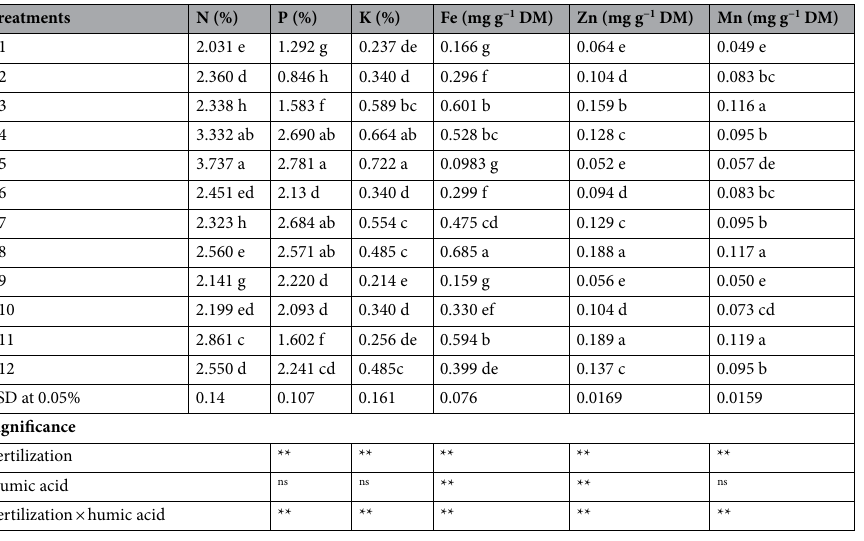
Table 3. The macro and micro-nutrient content of coriander plants is influenced by chemical and organic fertilizers and humic acid application (an average over the two years). T1 without fertilizer × without HA (control), T2 without fertilizer × HA before flowering, T3 without fertilizer × HA at beginning of flowering, T4 vermicompost × without HA, T5 vermicompost × HA before flowering, T6 vermicompost × HA at beginning of flowering, T7 Livestock manure × without HA, T8 Livestock manure × HA before flowering, T9 Livestock manure × HA at beginning of flowering, T10 chemical fertilizer × without HA, T11 chemical fertilizer × HA before flowering, T12 chemical fertilizer × HA at beginning of flowering. *, ** and ns, significant at the 5% and 1% probability levels and non-significant, respectively. Different letters indicate significant differences according to LSD test P < 0.05.